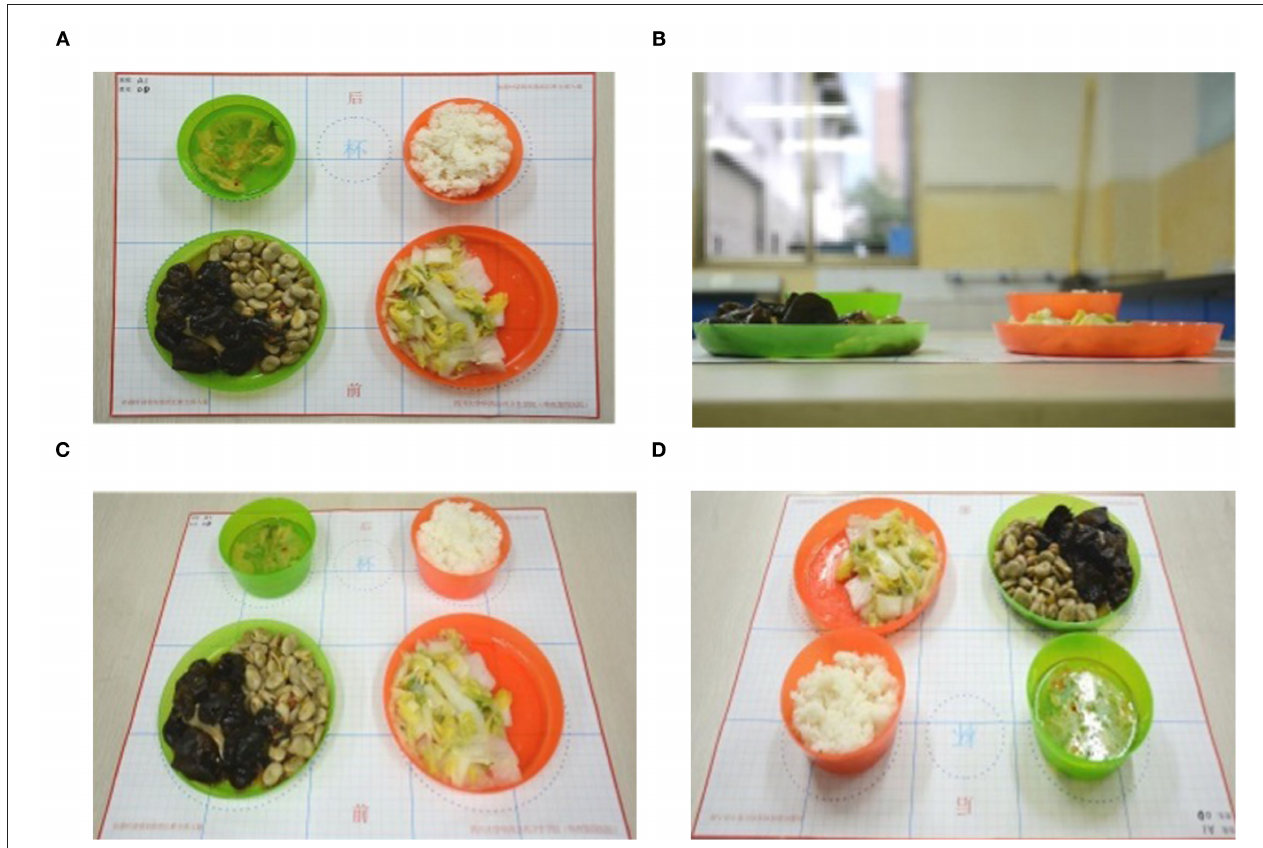
FIGURE 2 | An example of the standard food photographs from the four directions. (A) The top, (B) the side, (C) the 45-degree angle above the forward, and (D) the 45-degree angle above the